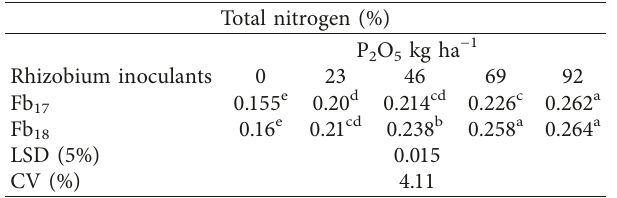
Table 6: Interaction effect of rhizobium inoculations and P fer- tilizer on available P.